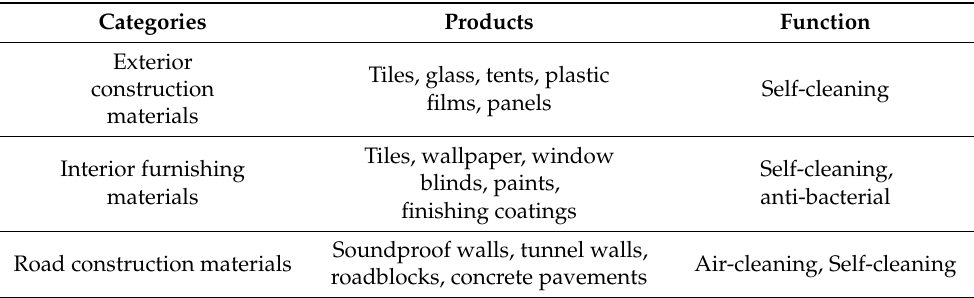
Table 1. Classification of TiO 2 -based photocatalytic construction and building materials [6].